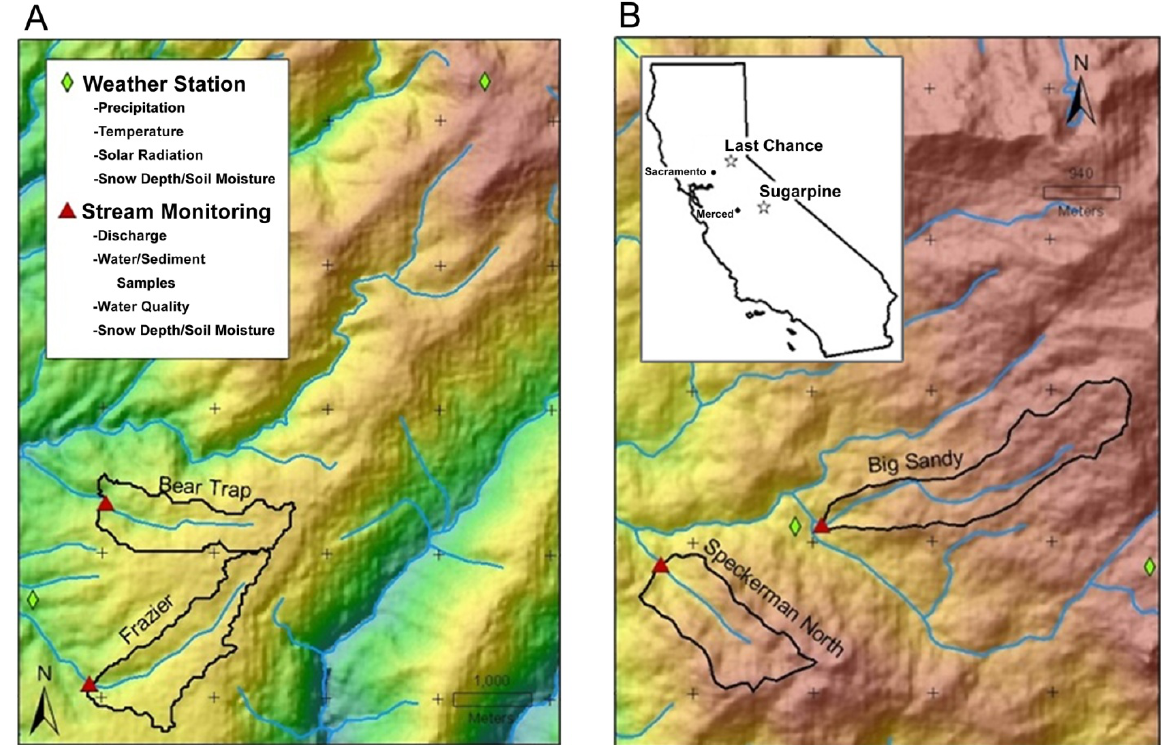
Figure 1. Map of Last Chance ( A ) and Sugar Pine ( B ) study